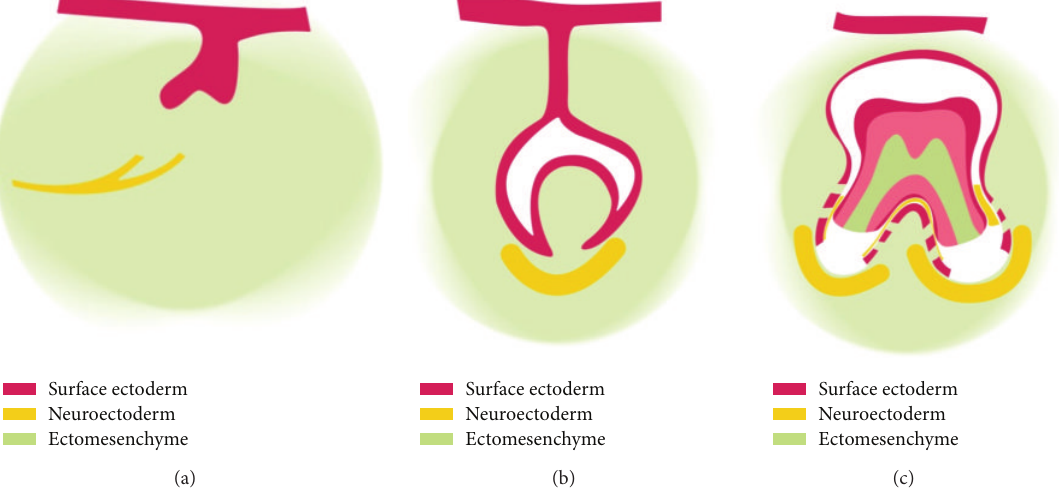
Figure 4: Schematic drawing of different stages ((a), (b), and (c)) in the formation of the human tooth primordium before eruption. Red indicates surface ectoderm/mucosa, green indicates ectomesenchyme, and yellow indicates peripheral innervation.